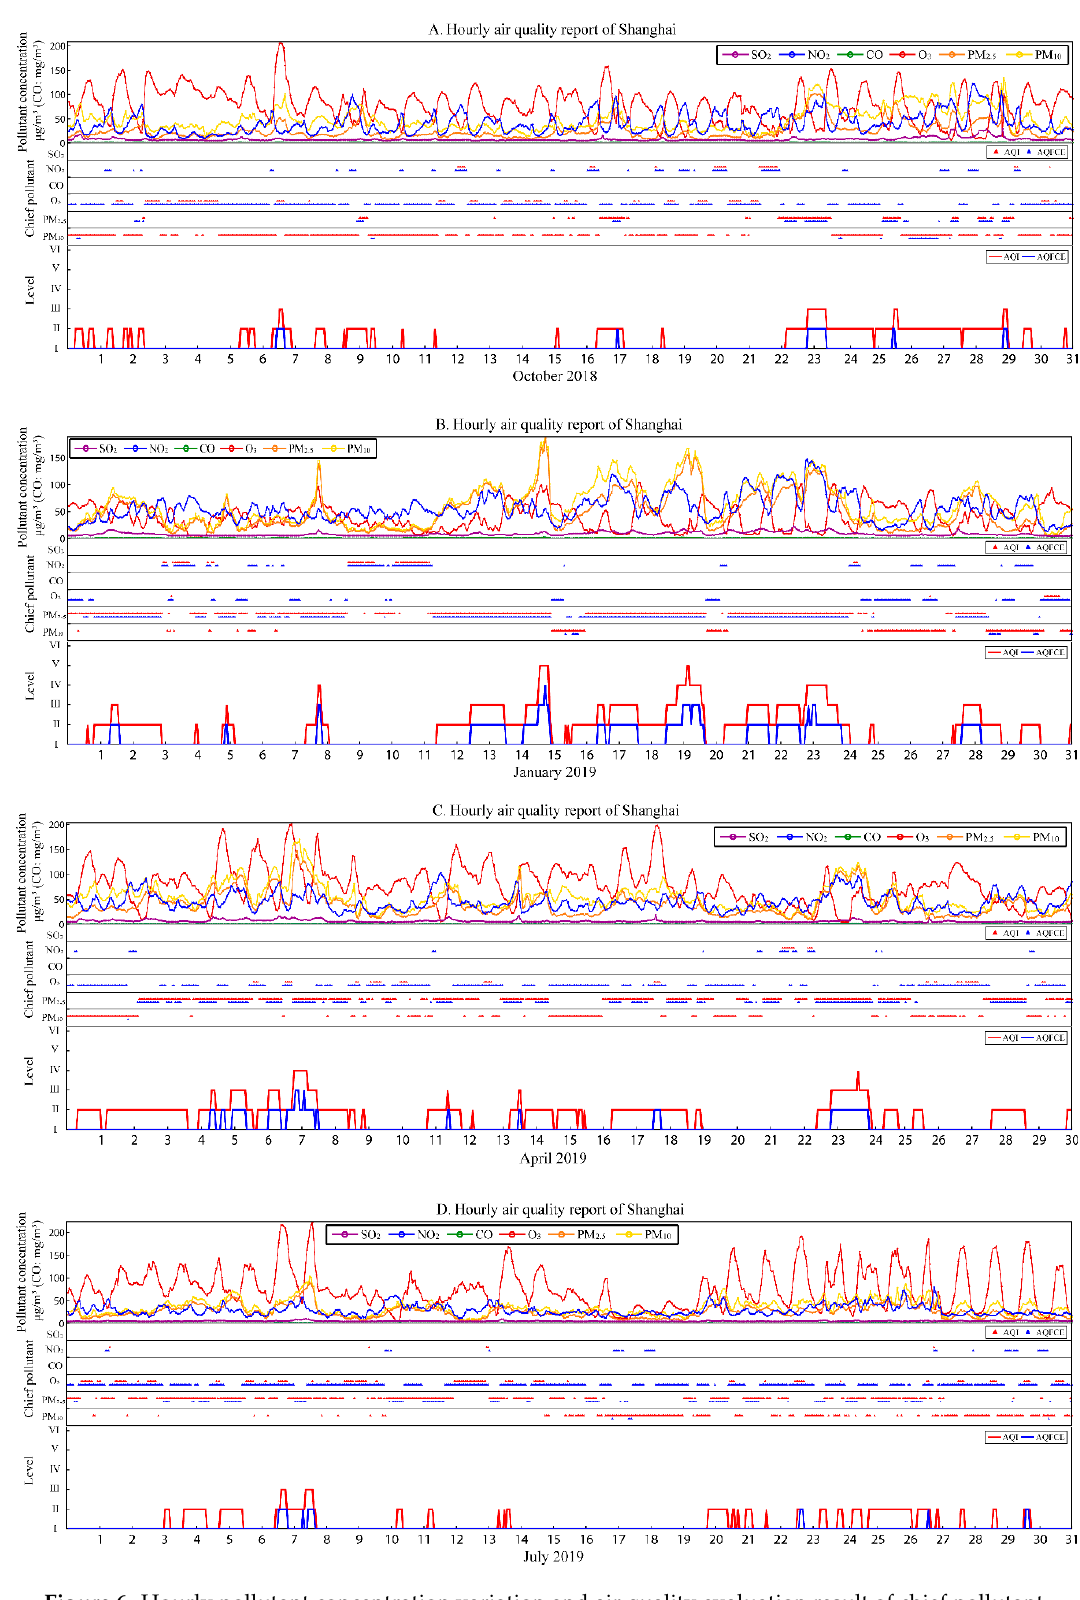
Figure 6. Hourly pollutant concentration variation and air quality evaluation result of chief pollutant and level of Shanghai.